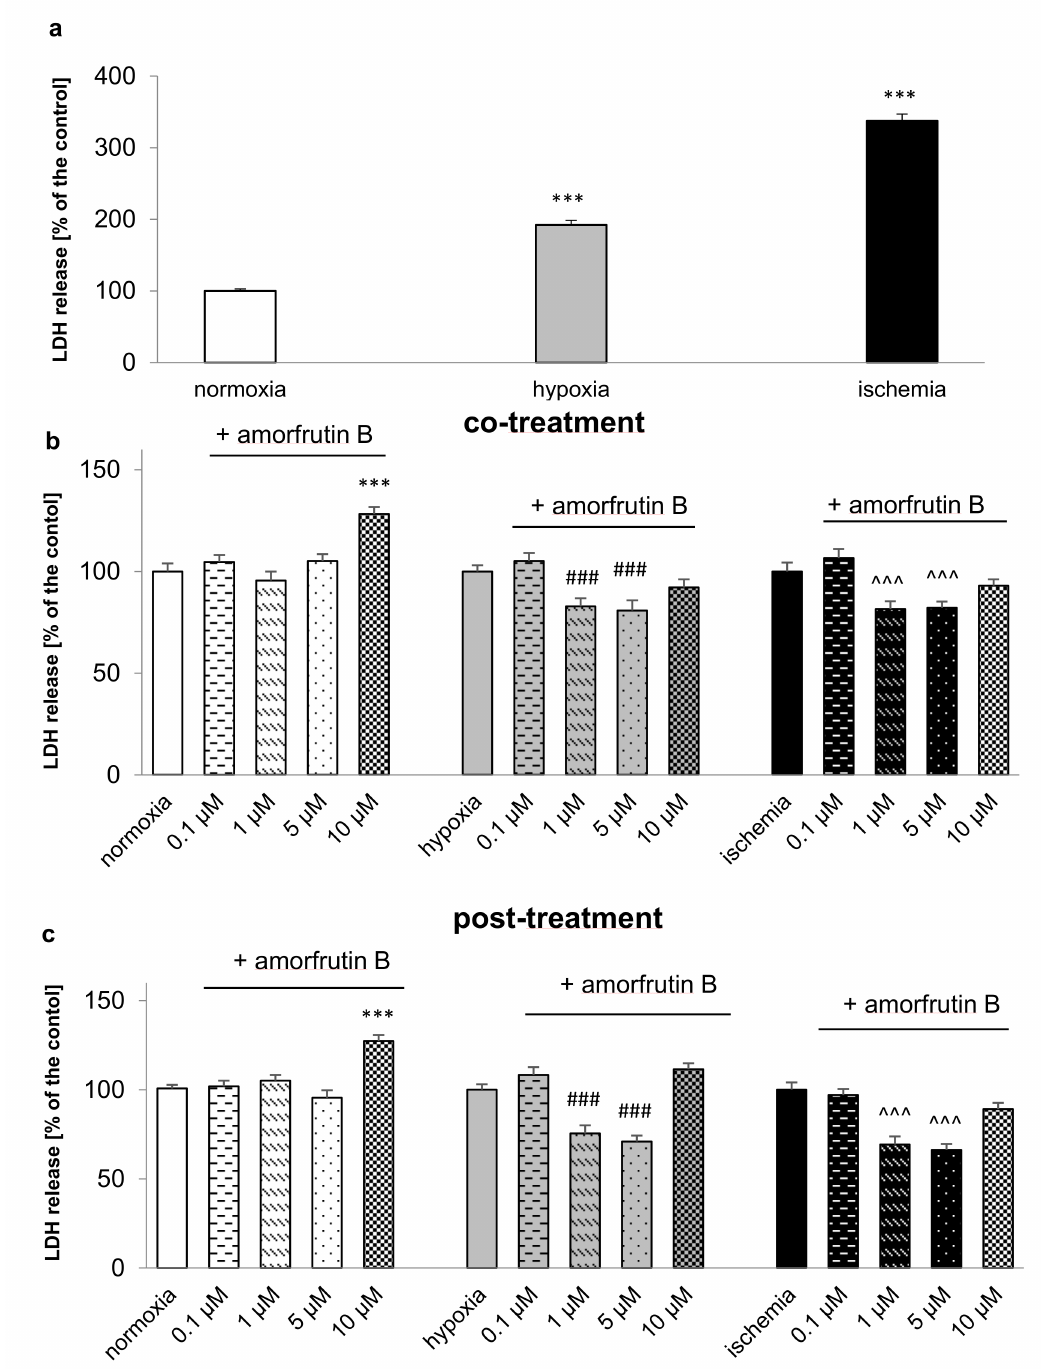
Figure 1. Time course and concentration-dependent response to hypoxia or ischemia and amorfrutin B treatment in mouse neocortical cells at 7 DIV. In both the co-treatment (treatment simultaneously with 6 h of hypoxia or ischemia) and post-treatment (treatment after 6 h of hypoxia or ischemia) paradigms, amorfrutin B (1 and 5 µ M) decreased hypoxia- and ischemia-induced LDH release, while under normoxic conditions, amorfrutin B (0.1–5 µ M) did not affect this parameter ( a – c ). The results are presented as a percentage of the control ± SEM of 3 independent experiments, consisting of 8–12 replicates per group. *** p < 0.001 compared to the control group, ### p < 0.001 compared to the cultures exposed to hypoxia, ˆˆˆ p < 0.001 compared to the cultures exposed to